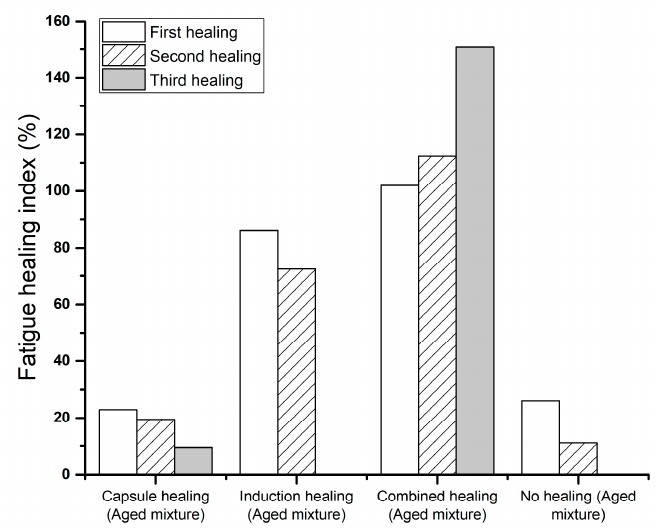
Figure 19. The fatigue healing index for various healing